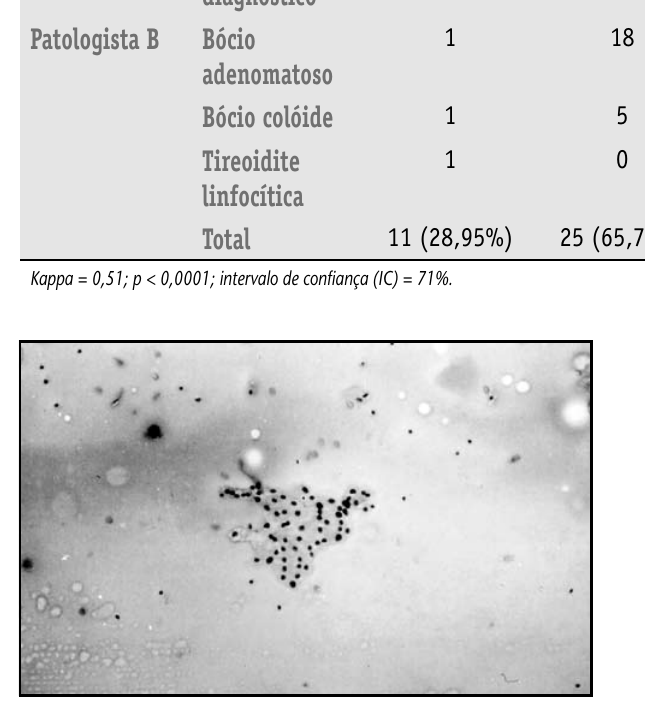
Figura 1 – O padrão citológico observado no material aspirado de tireóides normais foi compatível com bócio adenomatoso, exibindo células foliculares típicas,